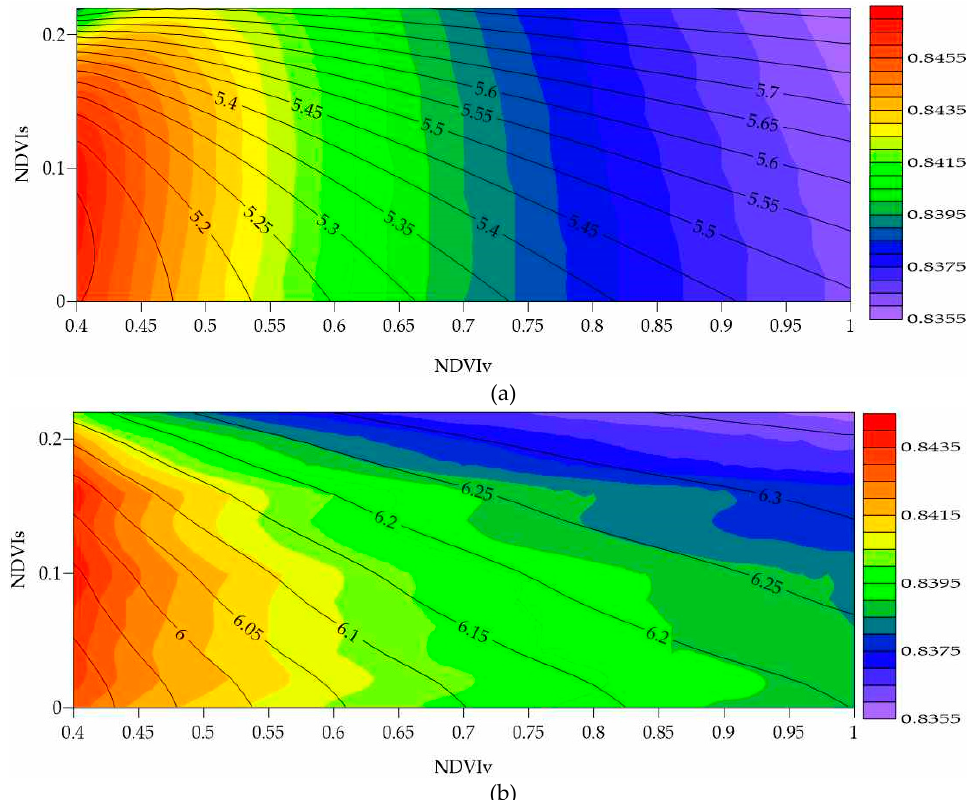
Figure 11 . Distribution of the correlation coefficient and RMSE between the estimated LST and the measured values. The colors represent the correlation coefficients, and the isoline and numbers represent the RMSE values; ( a ) is the estimated LST by the Kerr algorithm and ( b ) is the LST estimated by the B&L algorithm.